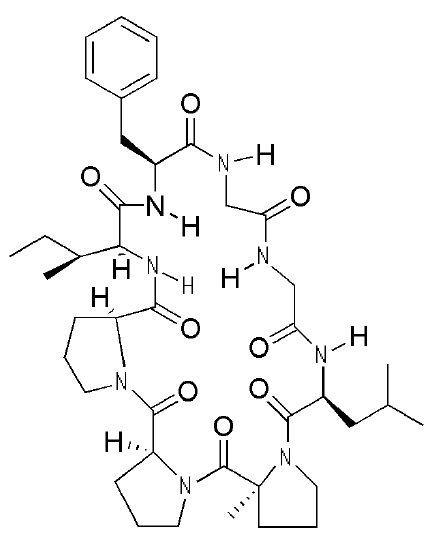
Figure 1. Chemical structure of Heterophyllin B (HB).